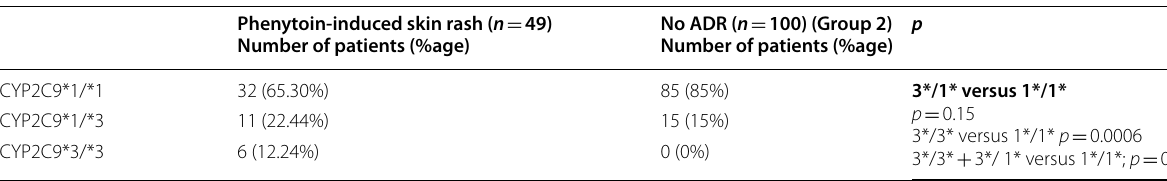
Patients with drug-related ADRs (both idiosyncratic and dose-related)